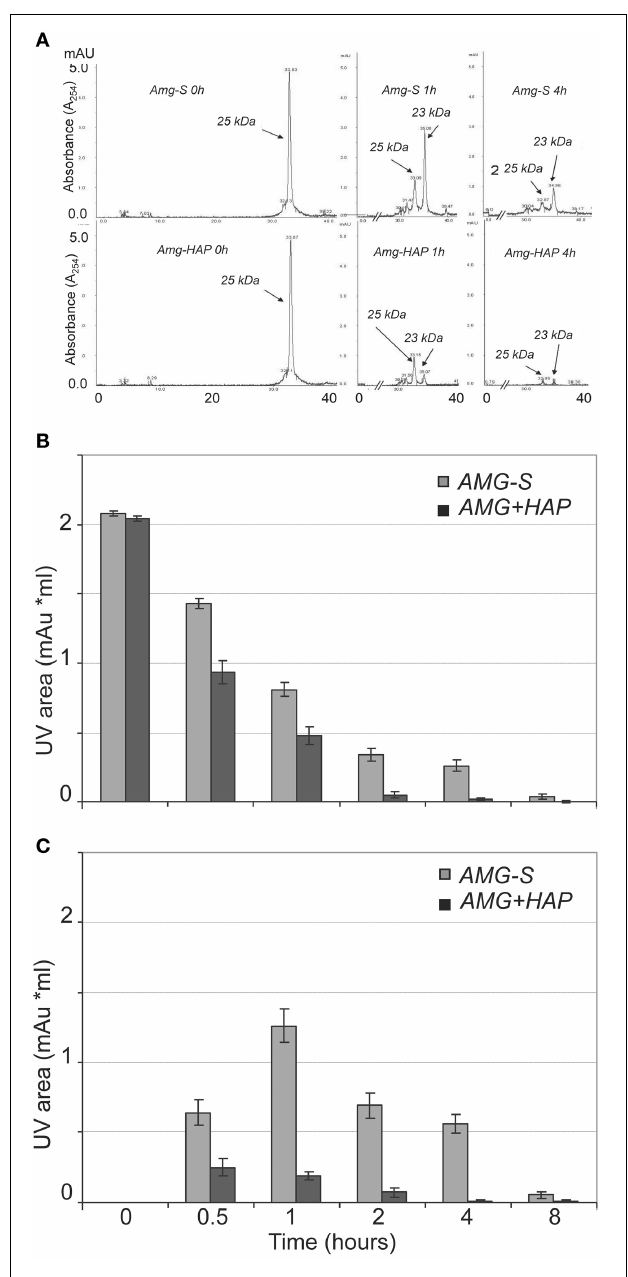
FIGURE 3 | MMP-20 hydrolysis of amelogenin in solution (AMG-S) and bound on HAP (AMG-HAP) were digested and quantified by HPLC. (A) HPLC peaks of 25 and 23kDa amelgenins after 1 and 4h of digestion. (B) Quantified UV areas of 25kDa amelogenin substrate after digestion. (C) Quantified UV areas of 23kDa amelogenin derivative during digestion.